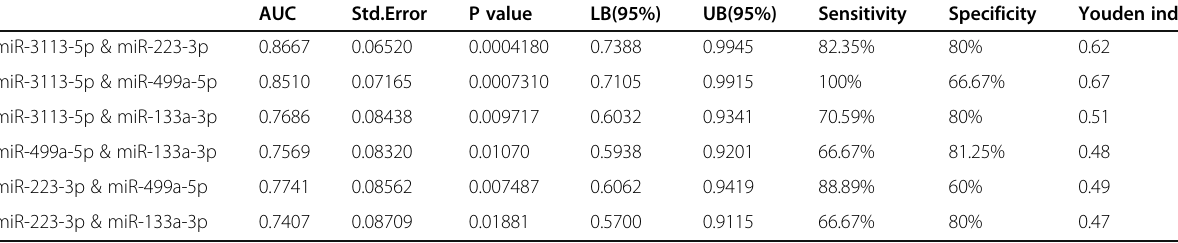
AU C Area under the curve, LB Lower bound, UB Upper